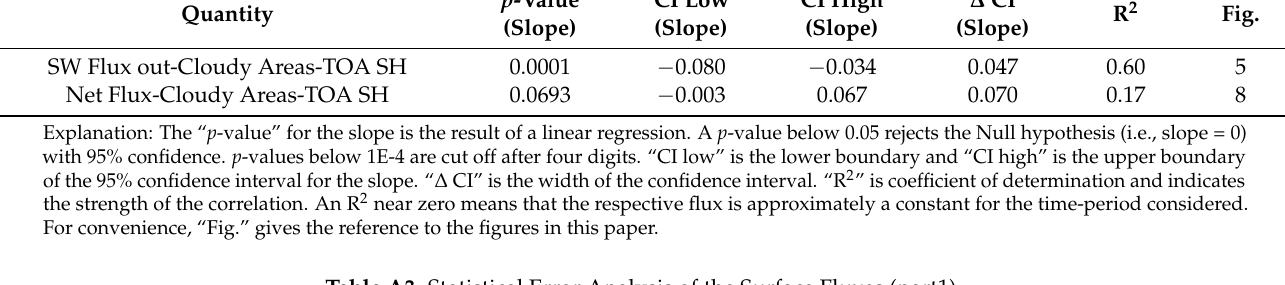
Table A3. Statistical Error Analysis of the Surface Fluxes (part1).